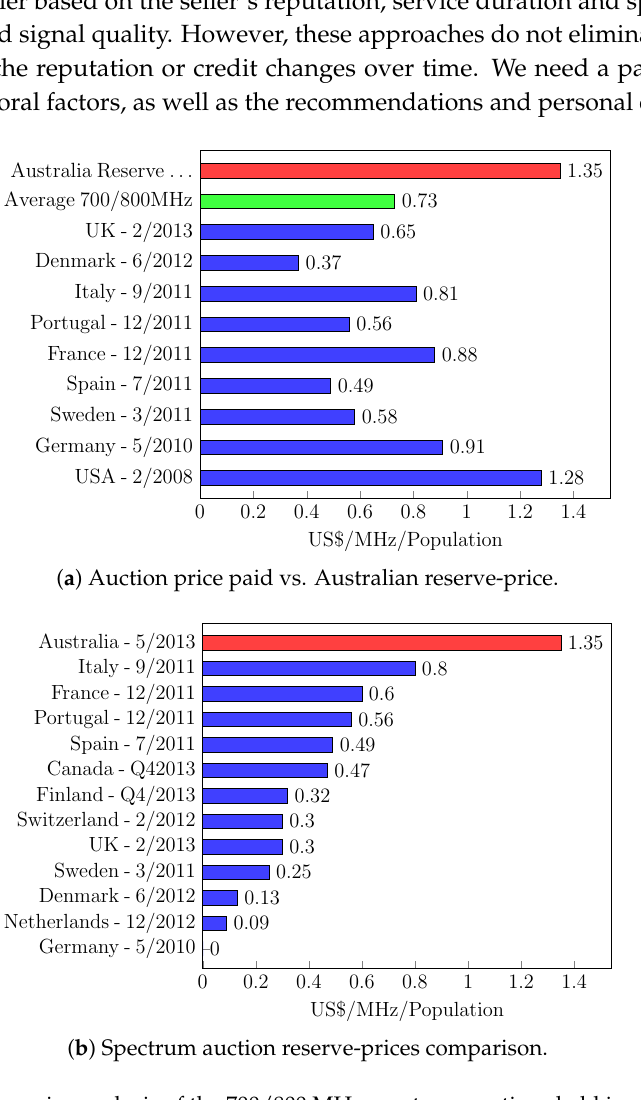
Figure 2. The reserve price analysis of the 700/800 MHz spectrum auctions held in various